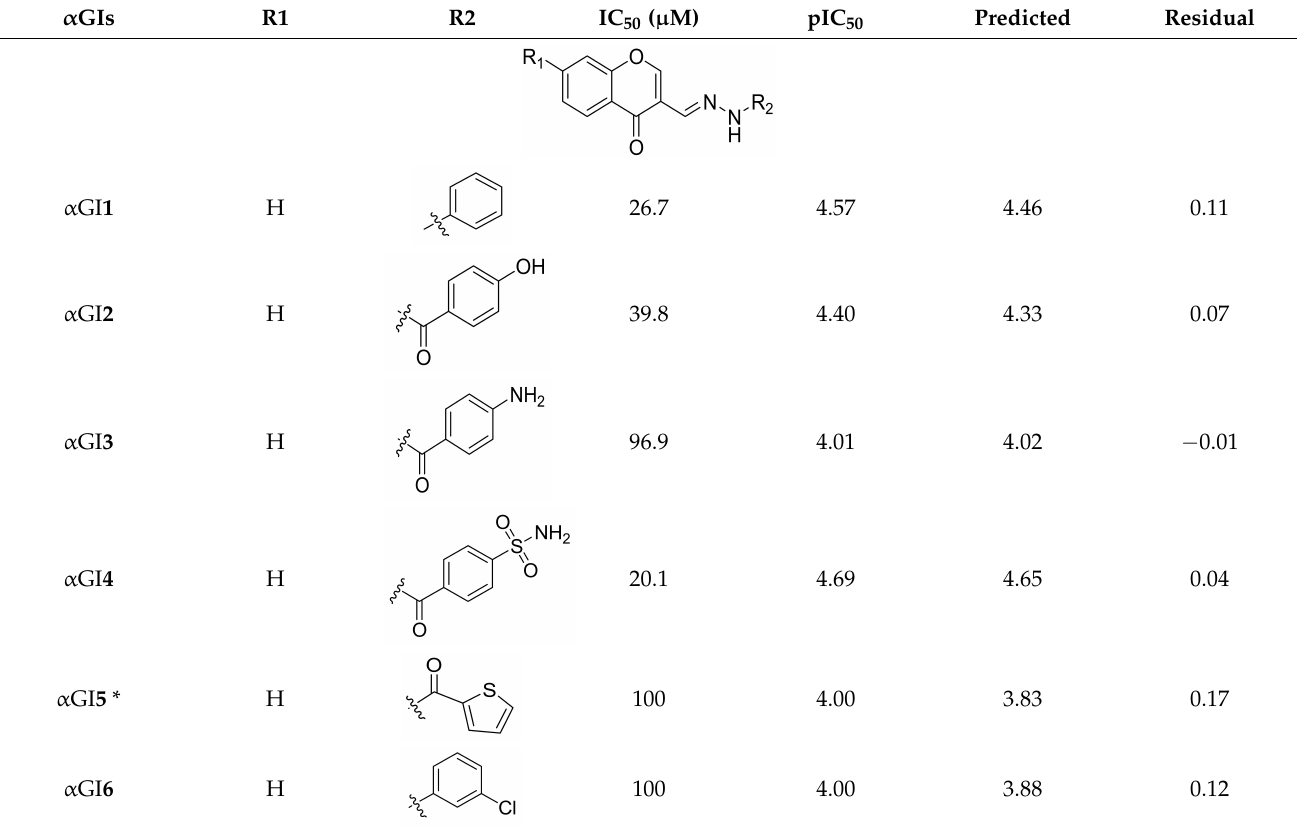
Table 1. The chemical structures, α -Glucosidase inhibitory activities, QSAR-predicted activities, and residual values of [ α -Glucosidase known Inhibitors ( α GIs )] used in QSAR modeling. α GIs R1 R2